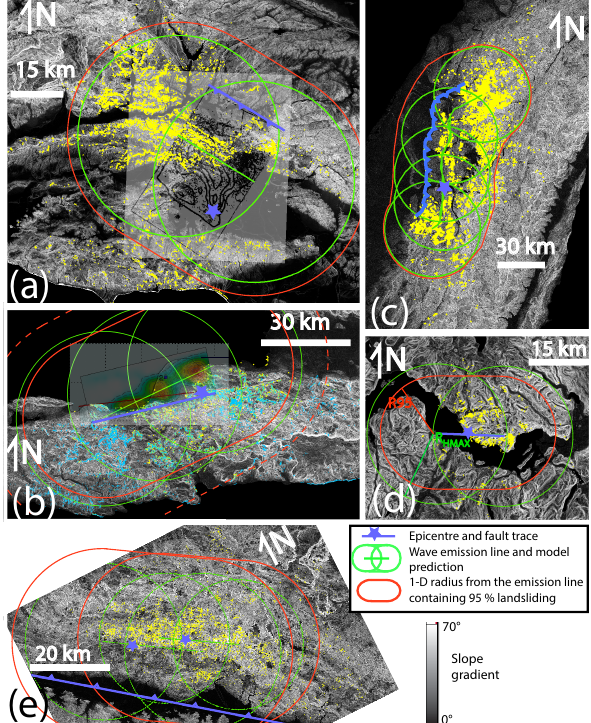
Figure 3. Distribution of landsliding (yellow polygons) and predicted landslide distribution area (green circles) for the Northridge (a) , Haiti (b) , Chi-Chi (c) , Aysen (d) , and Finis- terre (e) earthquakes. The background is a topographic slope gra- dient map derived from 30m Aster GDEM, provided by NASA, al- lowing us to locate flatlands where no landslides are expected even if the shaking threshold is exceeded. Emission line source and the area where the ground shaking is expected to be larger than a c are represented with green lines and circles, respectively. Red perime- ters show the area encompassing 95% of the total area of lands- liding defined by a uniform distance away from the wave emission line. For reference rupture slip distribution maps are shown for the Northridge and Haiti earthquakes (Wald et al., 1996; Hayes et al., 2010). For Haiti, in addition to the landslide inventory from Go- rum et al. (2013), we also show the one of Harp et al. (2016) (cyan polygons) and its associated R 95 with red dashed line. Note that the Aysen strike-slip fault is located only based on the focal mechanism and epicentre, and that the other solution (north-oriented) would give a similar radius for R 95 .